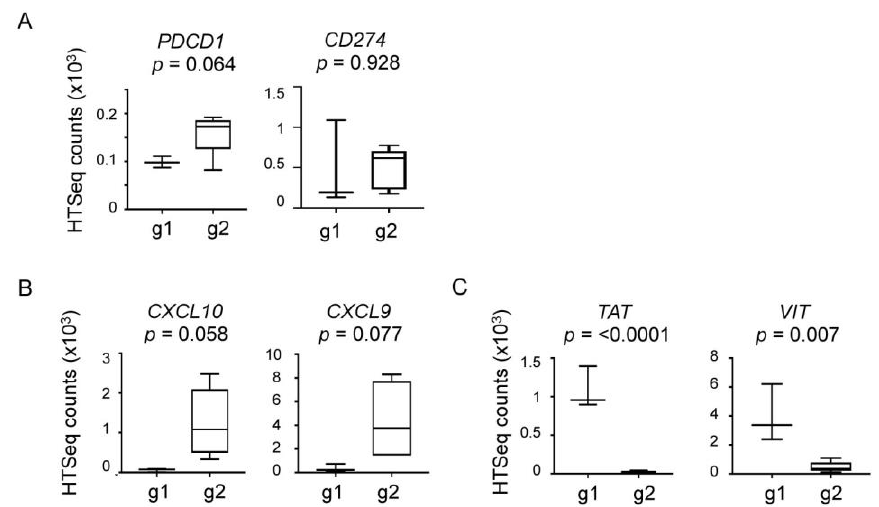
Figure 3. Expression levels of the genes in Group 1 vs. Group 2 tumors. ( A ) PDCD1 and CD274 , ( B ), CXCL10 and CXCL9 , and ( C ), TAT and VIT . Box plots were generated using the HTSeq counts of each gene. g1, Group 1; g2, Group 2; p values were determined using unpaired t -test.